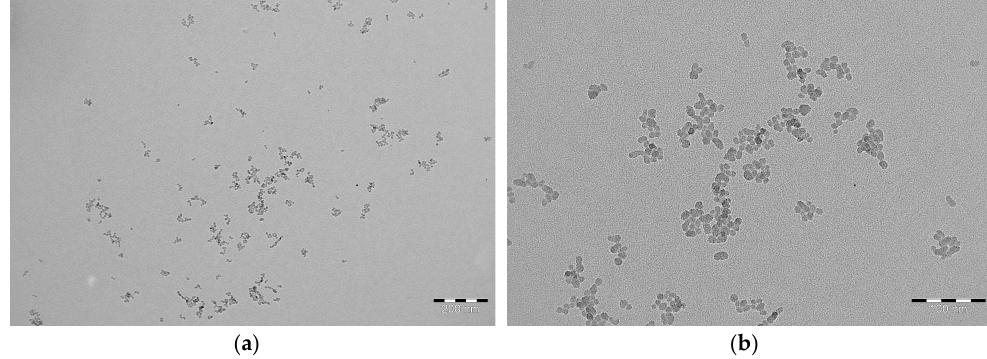
Figure A2. ( a ) TEM micrograph of the silica sol before gelation. Scale bar, 200 nm. ( b ) TEM micrograph of the silica sol before gelation. Scale bar, 100 nm.